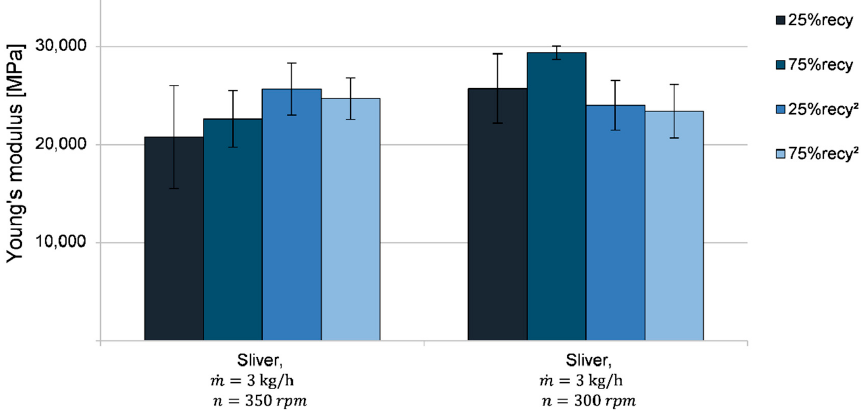
Figure 11. Young’s moduli of specimens produced in the single ‐ stage process with varying recycling content of the matrix.